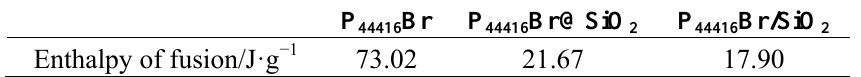
Br, P Br@SiO 44416 44416